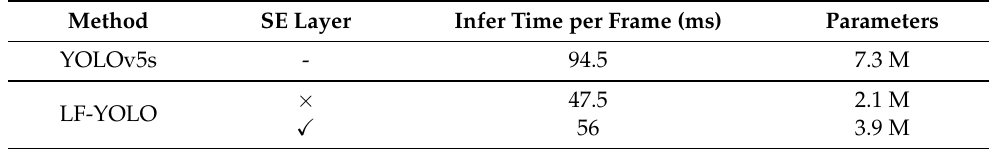
Table 2. Results for different network operating efficiencies.